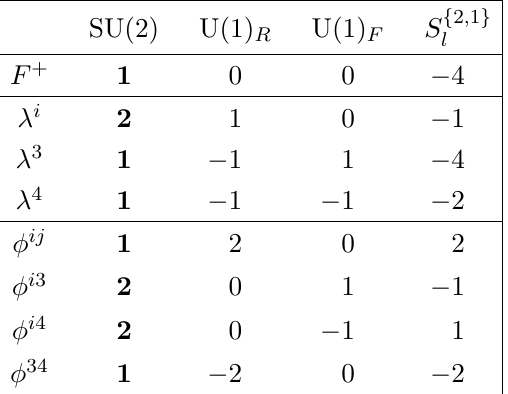
Table 6 . The charges carried by the component (cid:12)elds of the N = 4 super Yang-Mills multiplet under the S f 2 ; 1 g S-fold operator (in units of (cid:25)=k ) and the invariant SU(2) F (cid:2) U(1) R (cid:2) U(1) F (cid:26) SU(4) l (cid:13)avour/R-symmetry